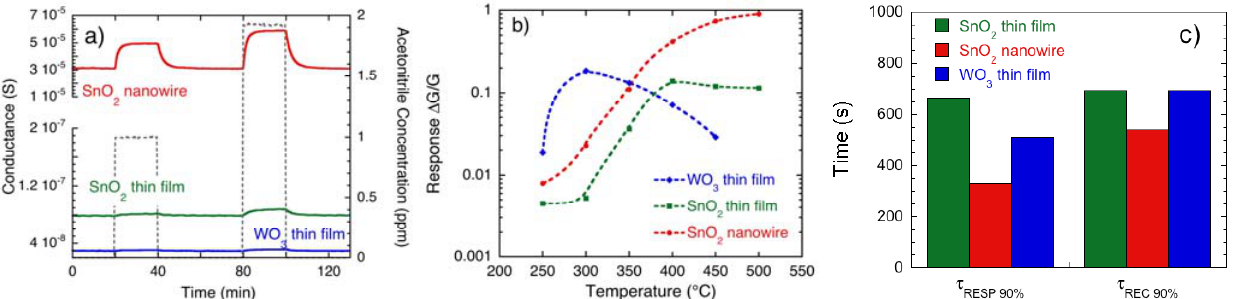
Figure 7. Response of sensors based on SnO thin film to acetonitrile (a simulant for cyanide compounds): ( a ) dynamic responses measured at the sensor temperature of 450 °C; ( b ) temperature effects on response amplitude to 2 ppm of acetonitrile; ( c ) response and recovery times of sensors to 2 ppm of acetonitrile measured at the working temperature of 450